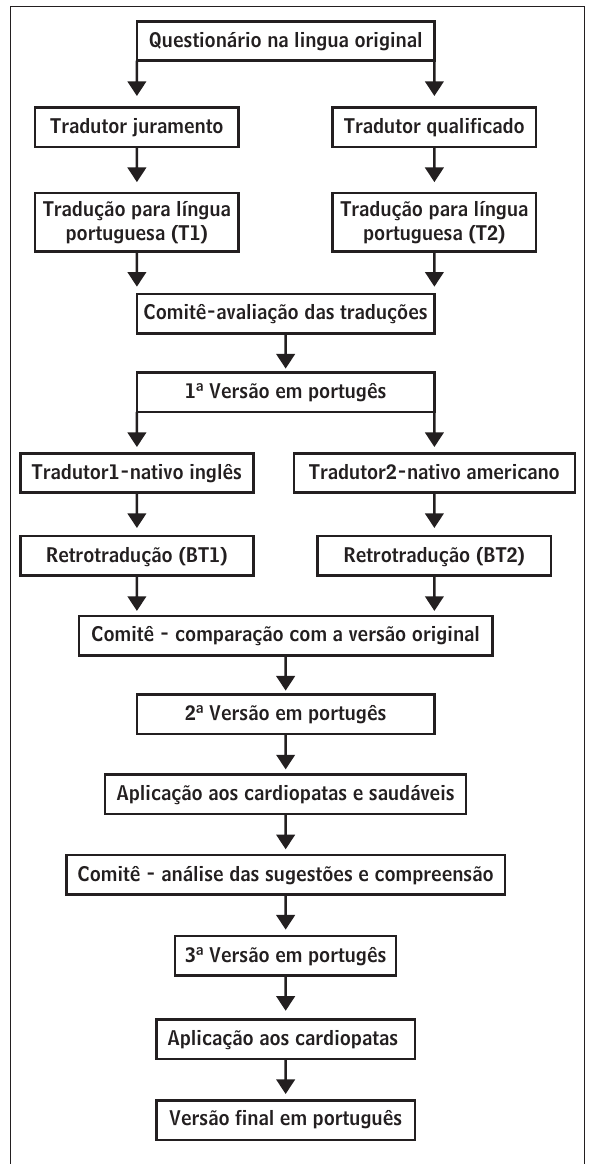
Figure 1 - Flowchart of translation and cross-cultural adap- tation process of DASI Source: Research